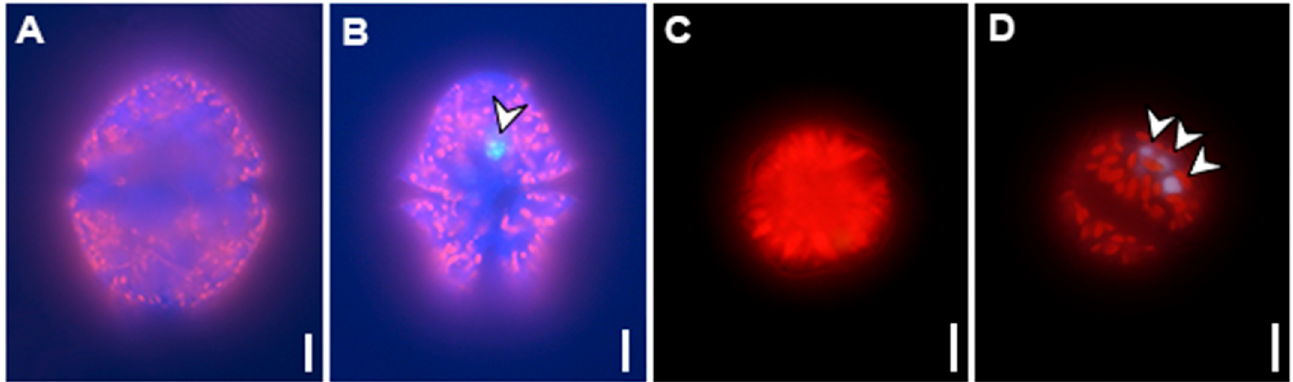
Figure 3. Fluorescence microscopy images of dinoflagellates non-feeding and feeding on LV-sIPN NPs. ( A , B ) Akashiwo sanguinea , ( C , D ) Alexandrium pacificum . ( A , C ) Cells with no NP, ( B , D ) Cells containing LV-sIPN NPs. The self-fluorescence of the cell is red and the LV-sIPN NPs are blue (arrow). Scale bars = 10 μ m.